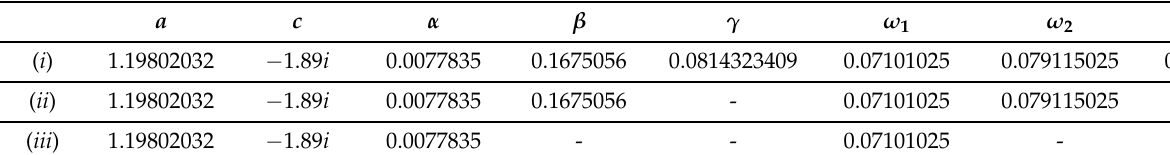
Figure 1. Cubic Julia sets in ( i ) Noor-orbit; ( ii ) Ishikawa-orbit; ( iii ) Mann-orbit. The parameters used in Figure 2 are as following in Table 2: Table 2. The parameters used in Figure 2.